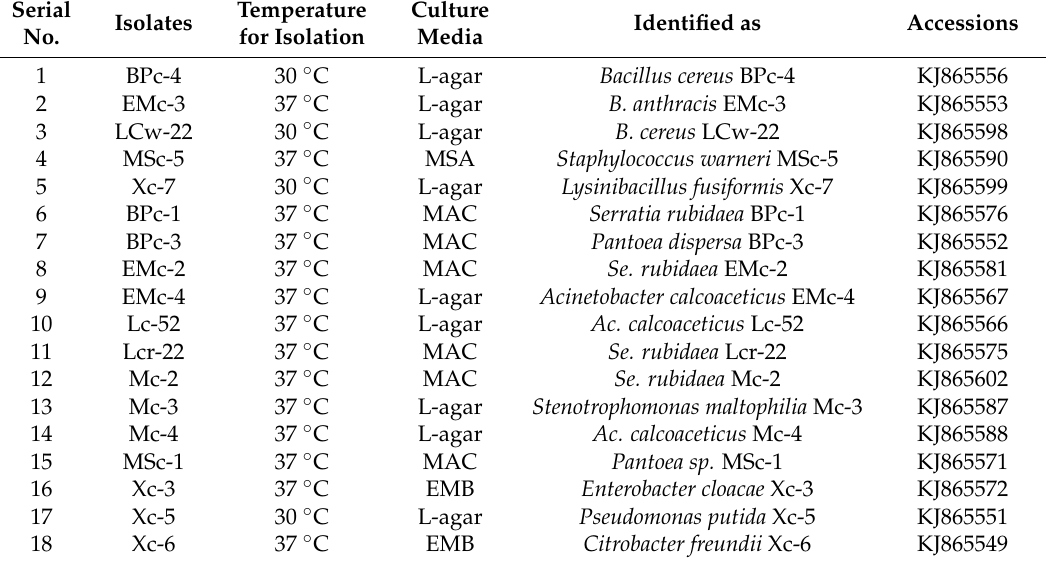
Table 1. 16S rRNA gene sequencing of bacteria isolated from carrot at different temperatures and in different culture media.